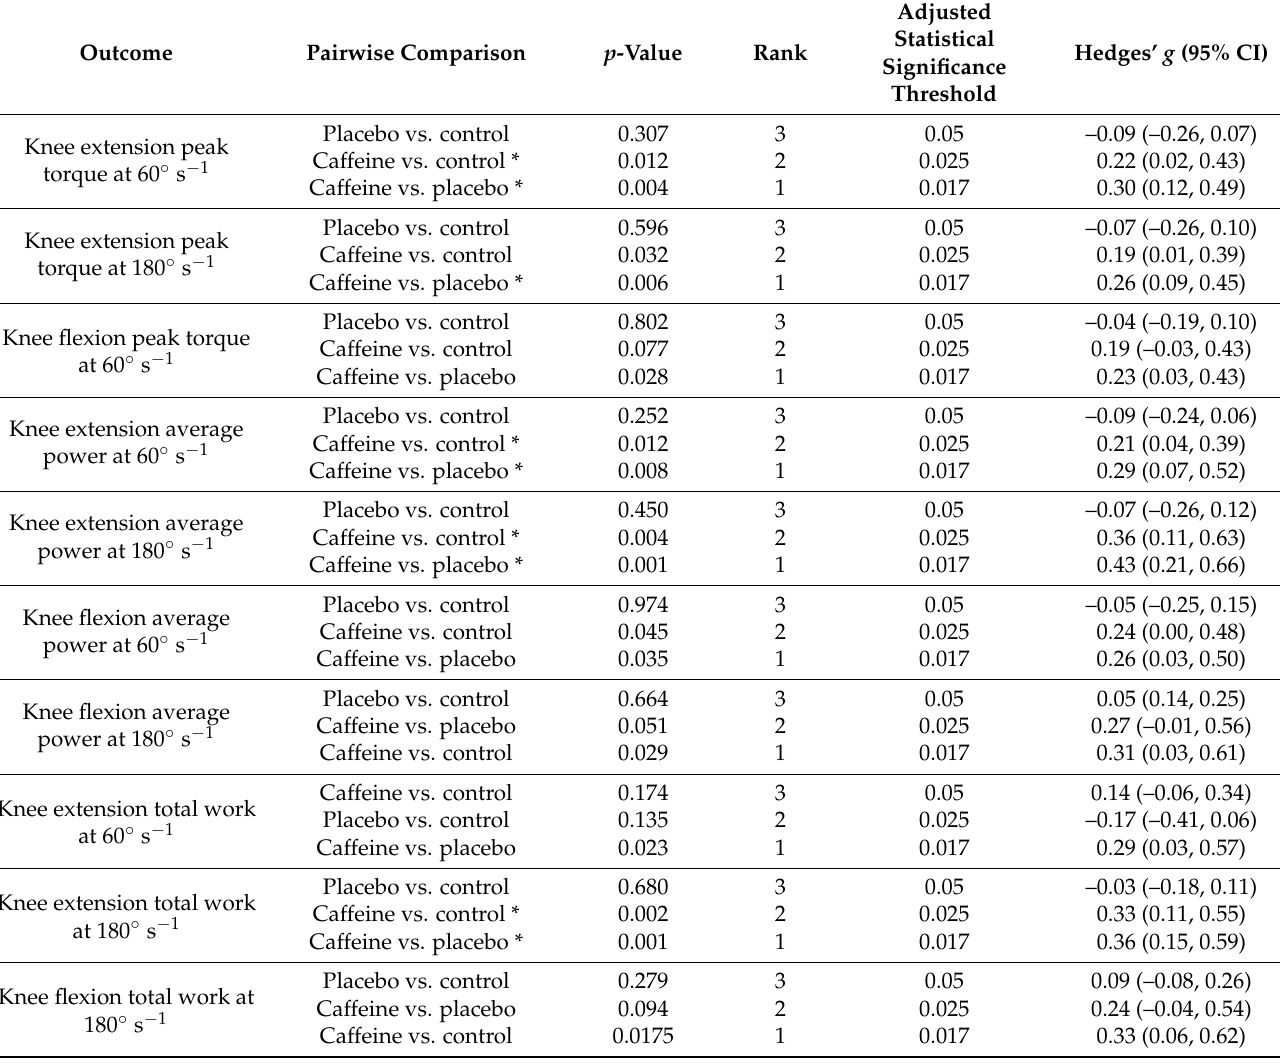
Table 2. Summary of the pairwise comparison performed for outcomes with a significant main effect from the one-way repeated measures ANOVA. For each outcome, the three pairwise comparisons, their p -values, ranks (ordered from highest to lowest), adjusted significance thresholds, and effect sizes are